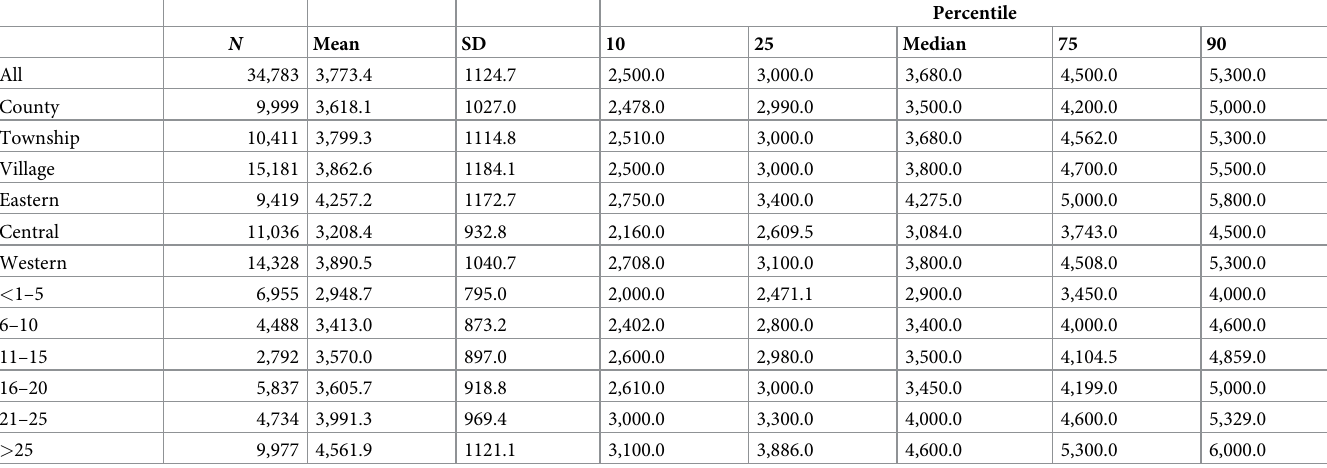
Table 8. Teachers’ income by total sample, school location, geographic region, and intervals of years in teaching